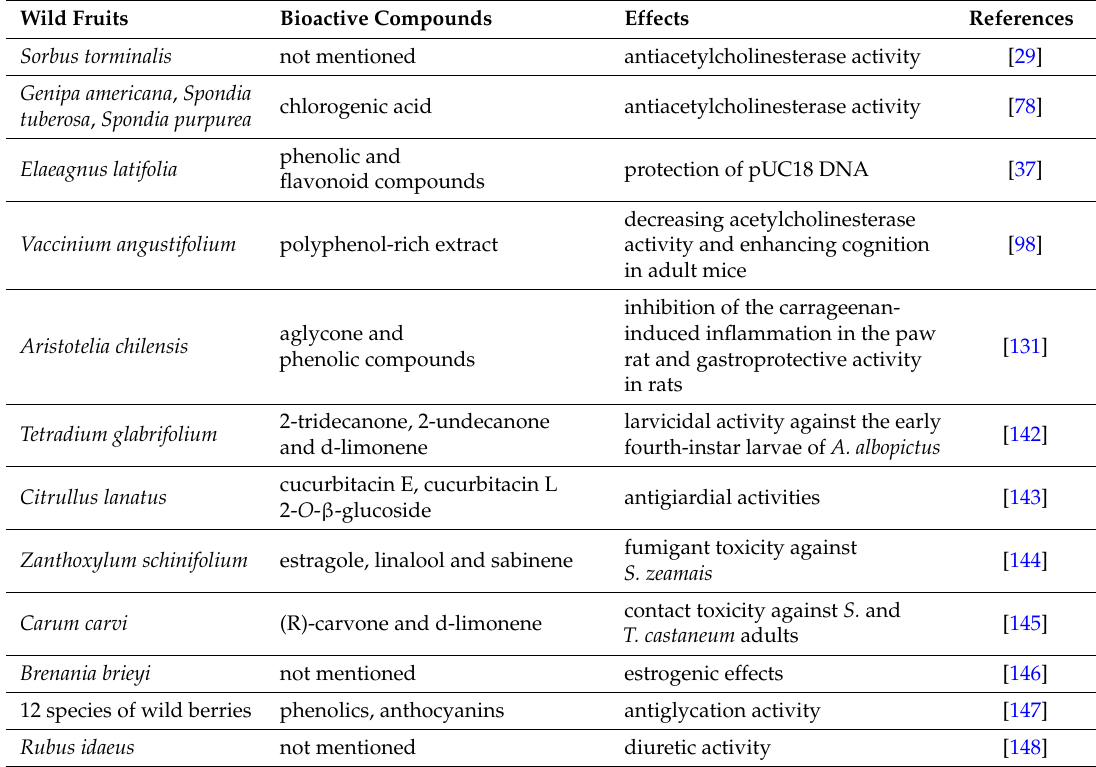
Figure 1. Some bioactivities of wild fruits. Table 5. Other bioactivities of some wild